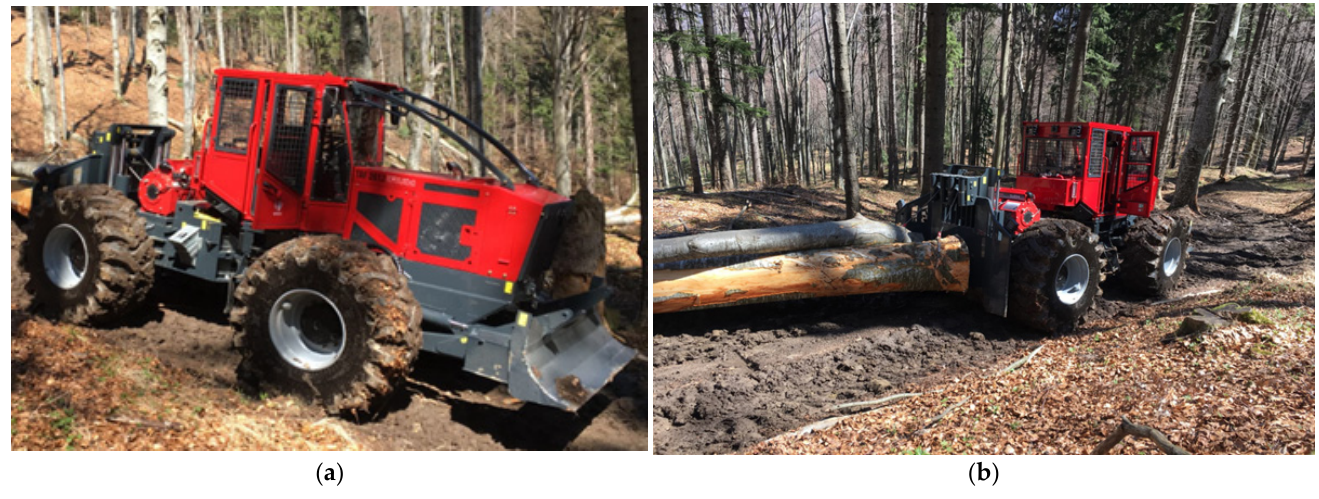
Figure 2. Description of the machine: ( a ) general overview on the TAF 2012 skidder; ( b ) TAF 2012 skidder during a loaded turn.